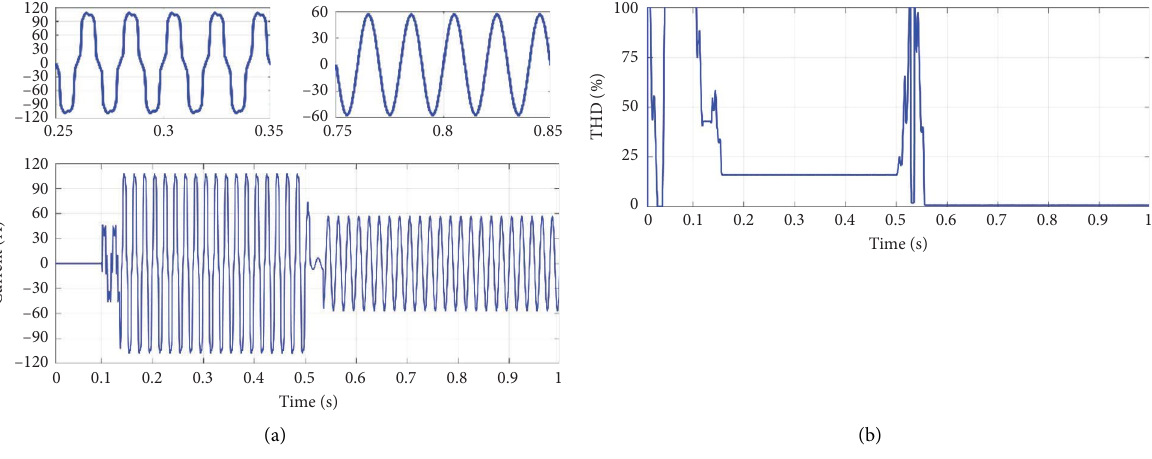
Figure 23: Filter current injected by PV system (a) and its THD (b).